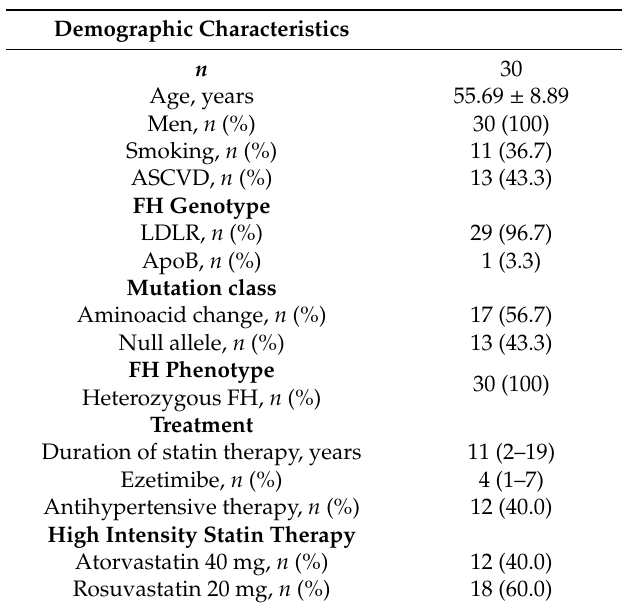
Table 1. Characteristics of the study population.